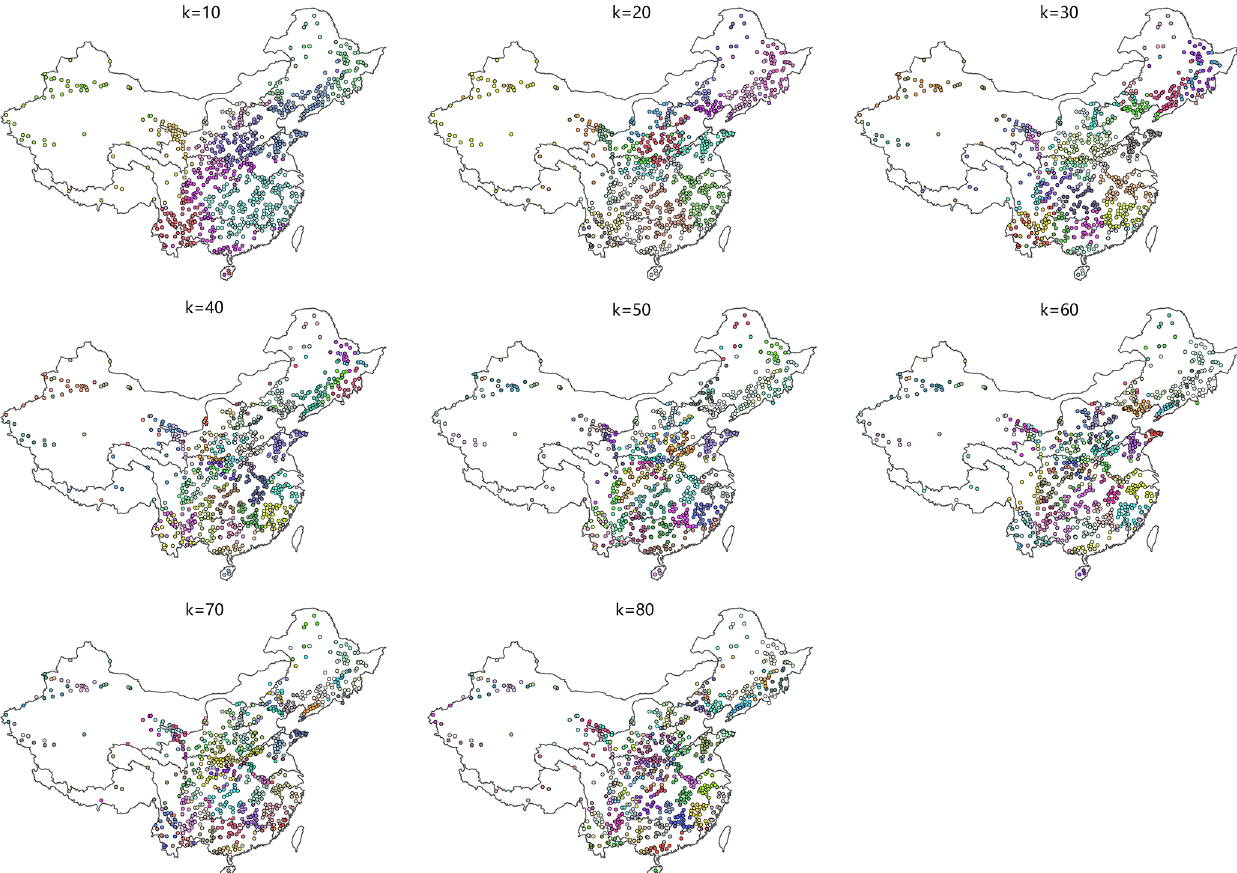
Figure A1. Catchment groups for all k values in Eq. (1). The points are the geometric centers of catchments.